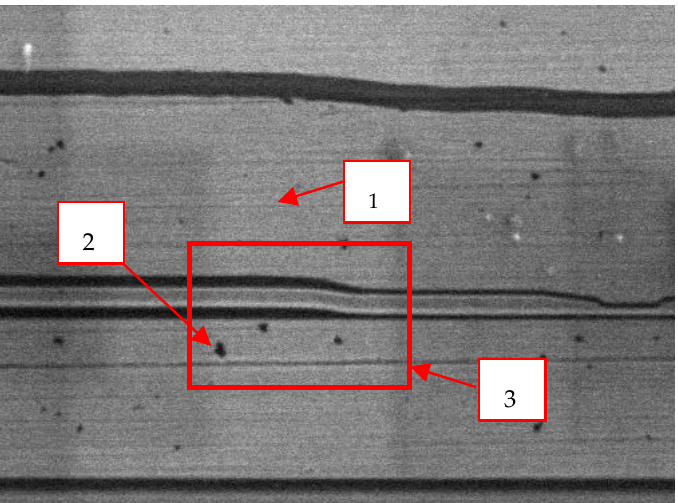
Figure 7. Secondary electron image of the pole area of the magnetic head (magnification: 40,000 × ).